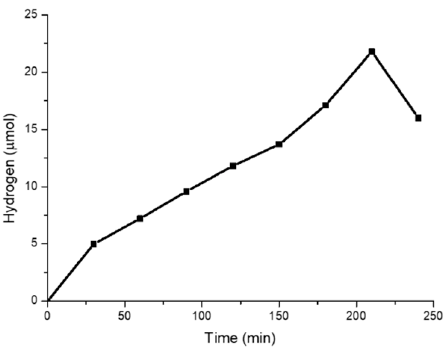
Figure 5. Time profile of H 2 production using the photocatalyst of SnP 6+ -embedded Nafion/Pt-TiO 2 ( 3 ) in the absence of SnP 6+ in the solution under visible light irradiation.